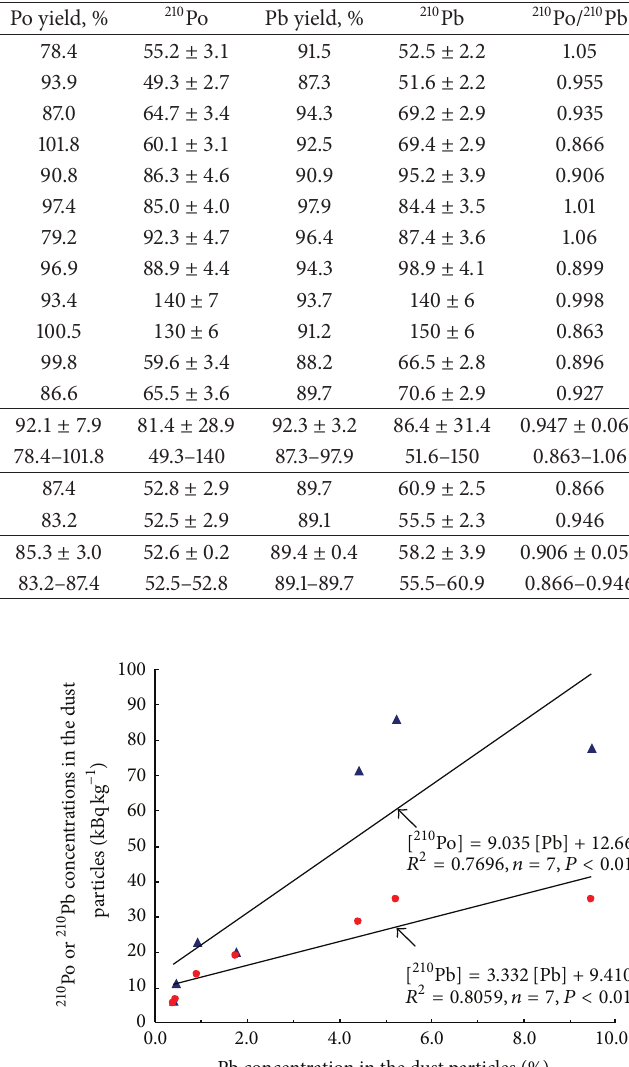
Table 9: The 210 Po and 210 Pb concentrations in Bqkg − 1 in soil samples (depth: 0–5 cm) collected from the area of the ILVA Taranto (SS1-SS6) and from Castel Romano Roma (SS7) on 2 November 2008.